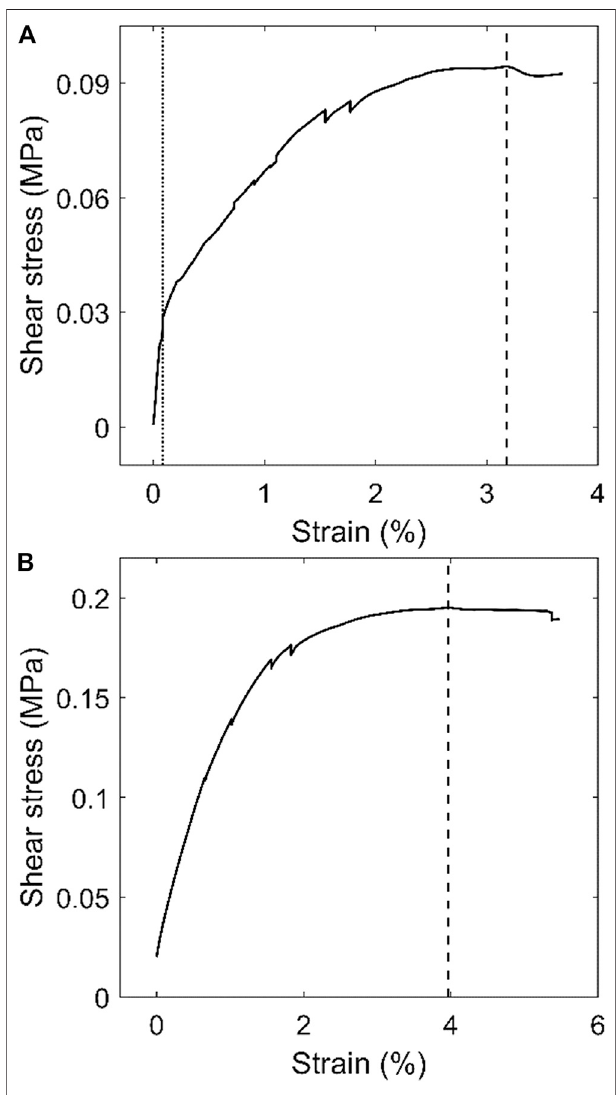
FIGURE 4 | Representative stress-strain curves from (A) Experiment 1, one of fi ve experiments in which strain rate was initially high, to accelerate the experiment, and then reduced (dotted line) to a lower value; strain rate at the peak stress (dashed line) was 2.9 ± 0.7 × 10 − 8 s − 1 , and (B) Experiment 9, conducted at a single strain rate of 8.6 ± 0.4 × 10 − 8 s − 1 .